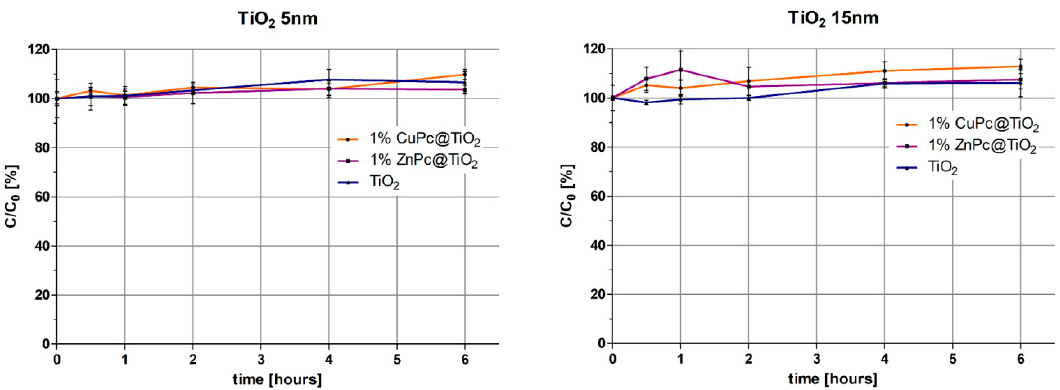
Figure 8. The changes in ibuprofen concentration after irradiation (665 nm light) of the solution containing a photocatalyst.